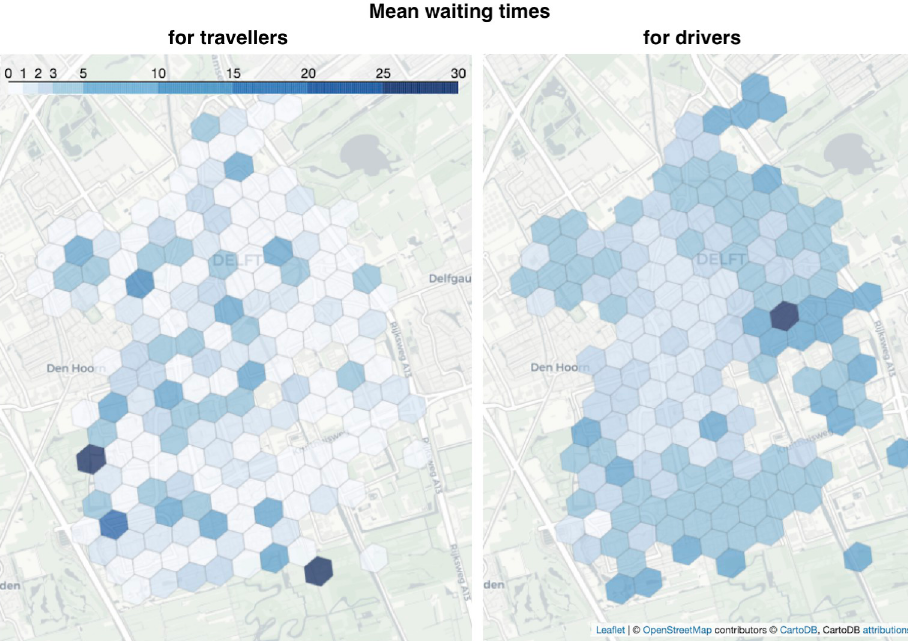
Fig 4. Average waiting time for travellers until the driver arrives (left) and for the driver, until they get requested (right). Dark denotes longer waiting times. Results from 20 replications of a four hour period simulation with 200 travellers and 10 vehicles in Delft, the Netherlands © OpenStreetMap